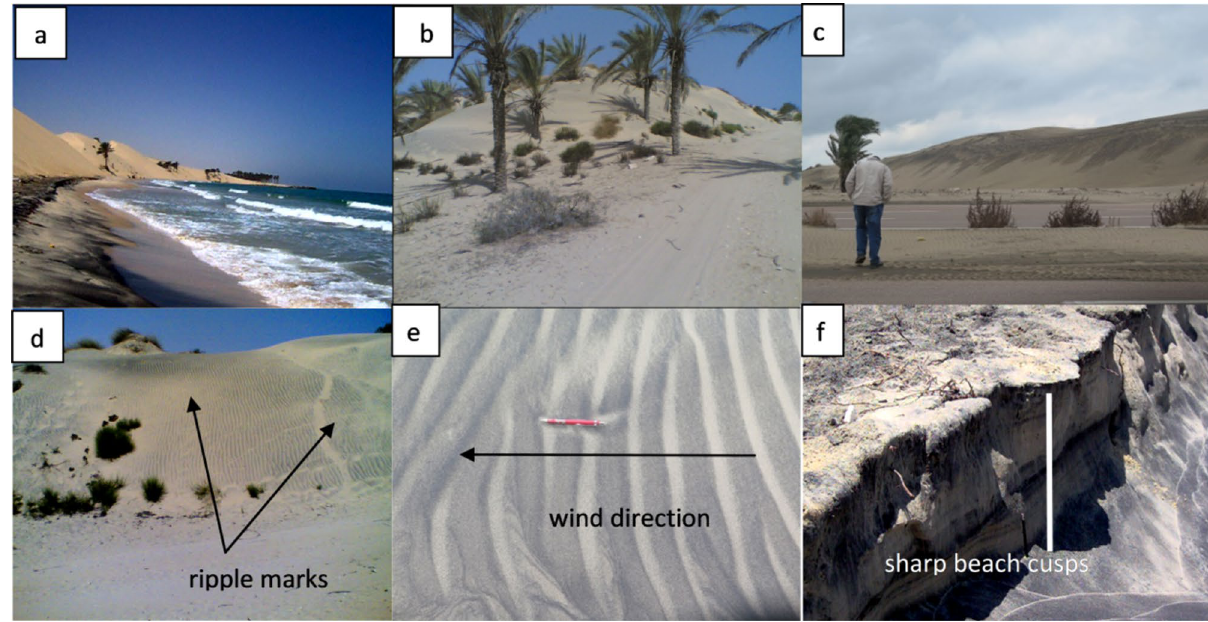
Figure 2. Photographs show: ( a ) linear sand dune with concave shape of coastline, ( b ) barchan sand dune ( c ) transverse dune, ( d ) sand dune with ripple marks on its limbs, ( e ) the ripple marks and ( f ) sharp beach cusps of about 75 cm